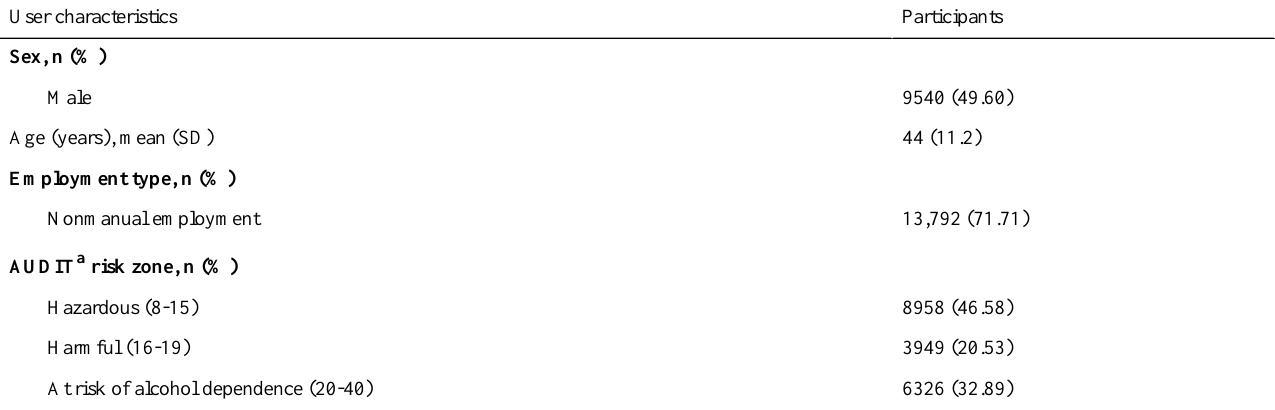
Table 1. User characteristics (N=19,233). ParticipantsUser